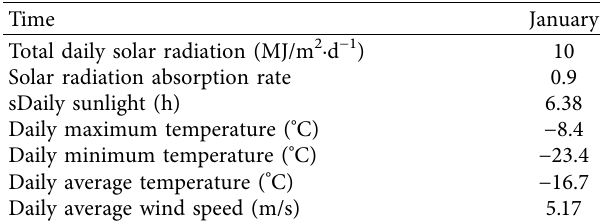
Table 3: Boundary condition